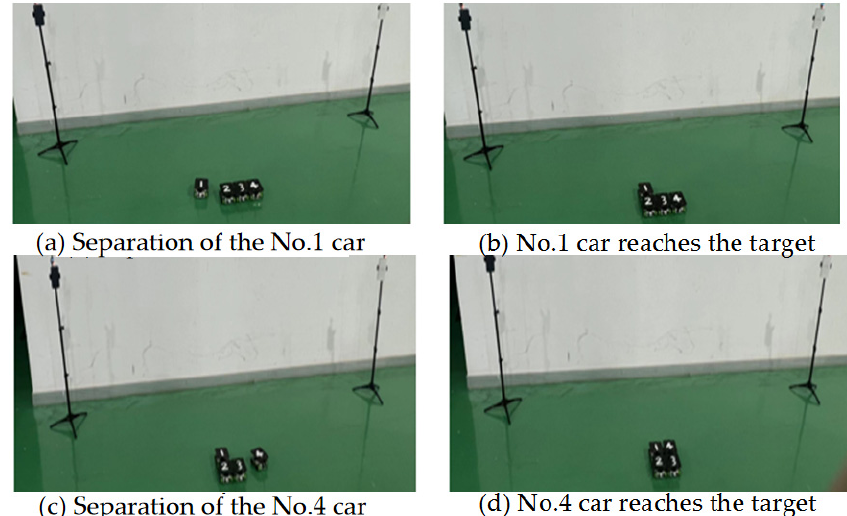
Figure 27. Configuration change process of modular vehicles.